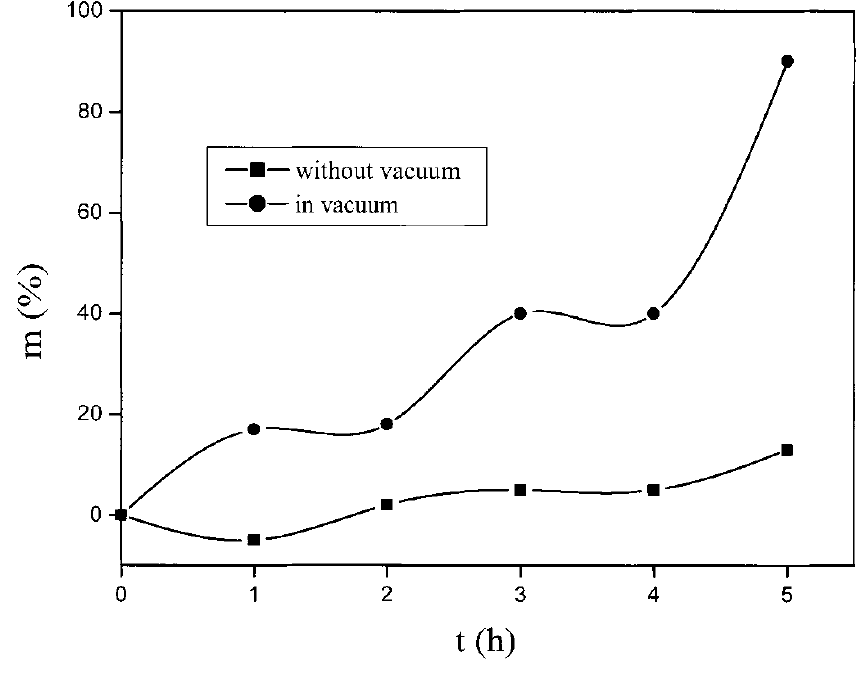
FIGURE 5 The effect of vacuum on m –